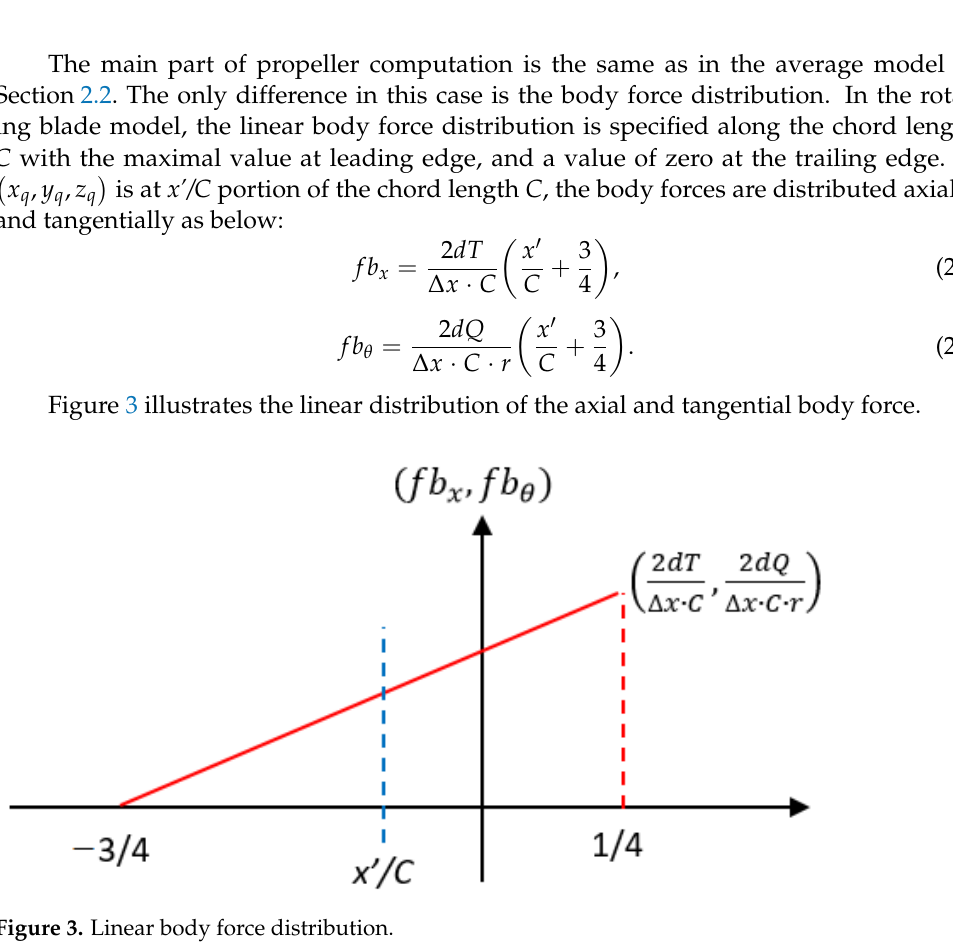
Figure 3. Linear body force